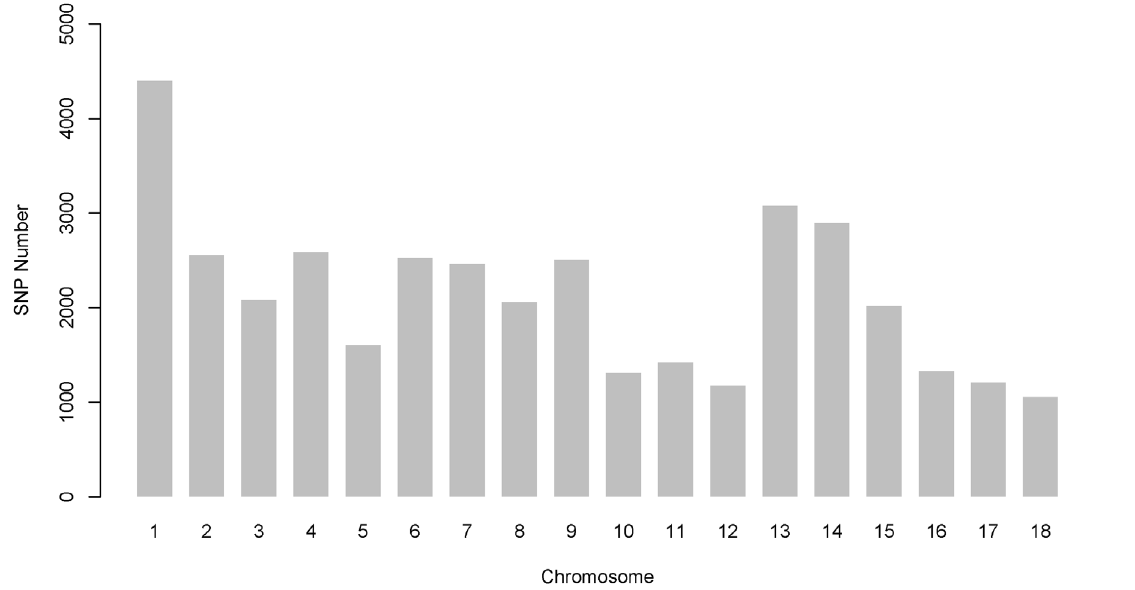
Figure 1. Number of single nucleotide polymorphisms (SNPs) per chromosome after quality control and